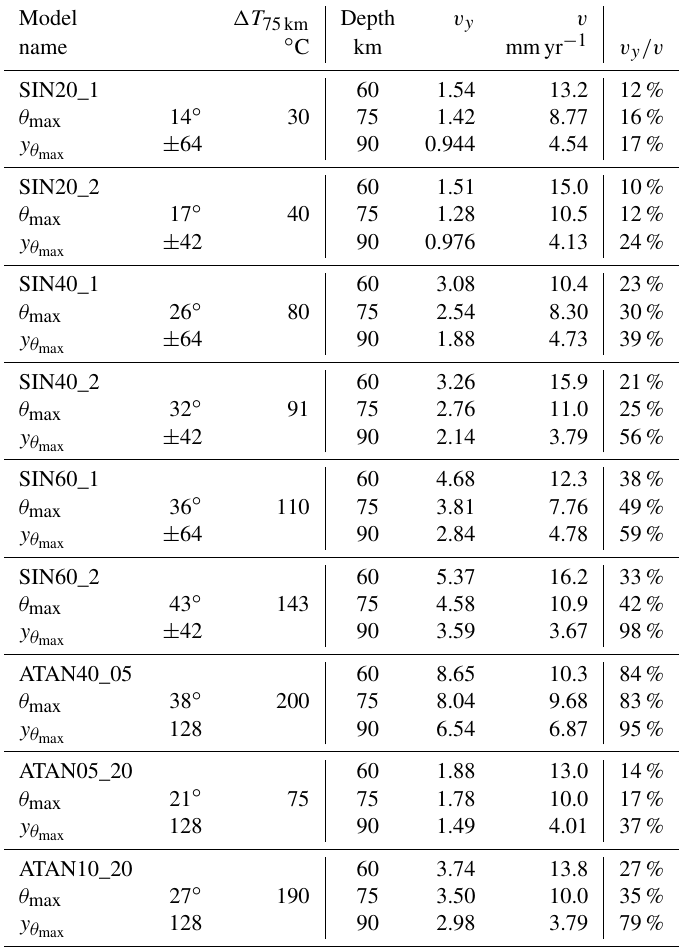
Table 3. Variation in v y in the mantle at different depths compared with the magnitude velocity at the same position. The variation in temperature at 75km of depth is also give to complete Table